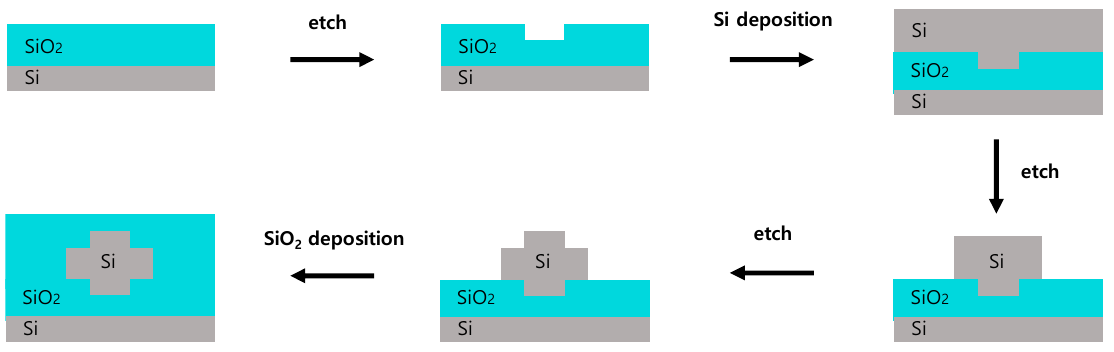
Figure 7. Fabrication process of the proposed waveguide.